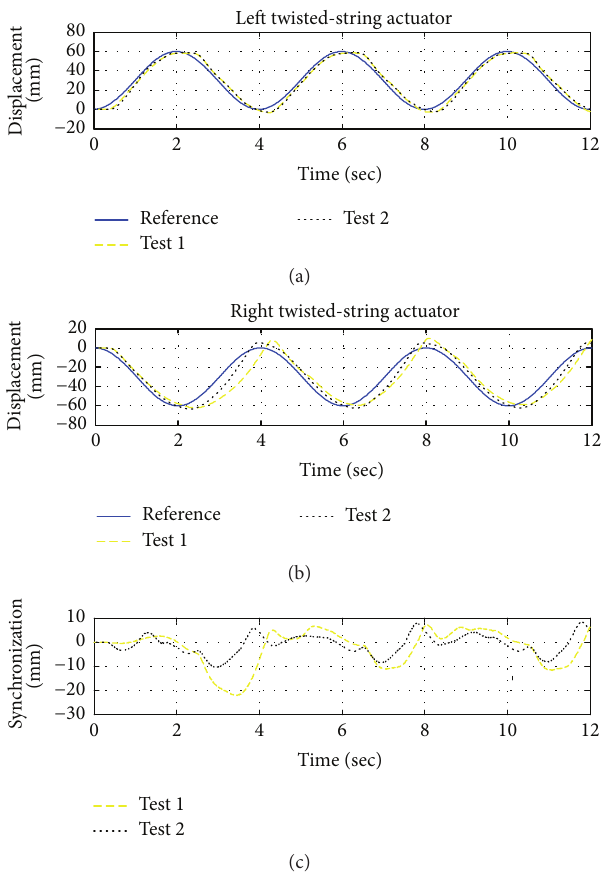
Figure 8: Experimental outcome of PID controller (sinusoidal motion): (a) comparison between reference trajectory and actual trajectories of left actuator; (b) comparison between reference tra- jectory and actual trajectories of right actuator; (c) synchronization errors between left and right